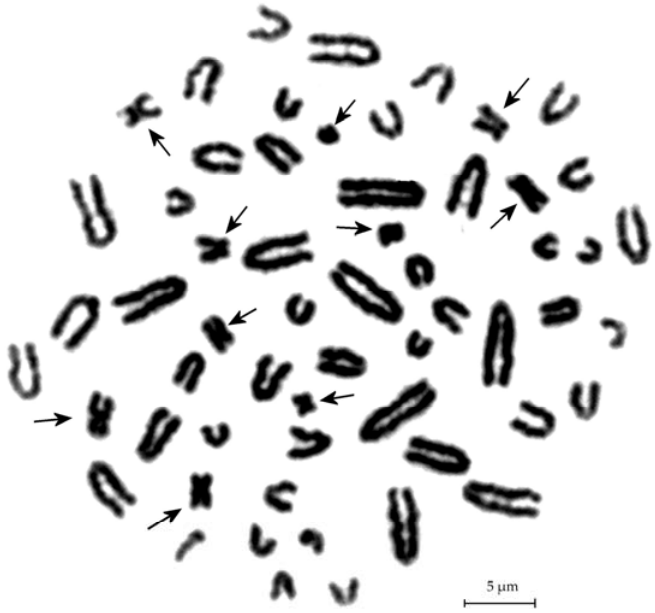
Figure 2. Metaphase plates of A. peninsulae with 10 different Bs.